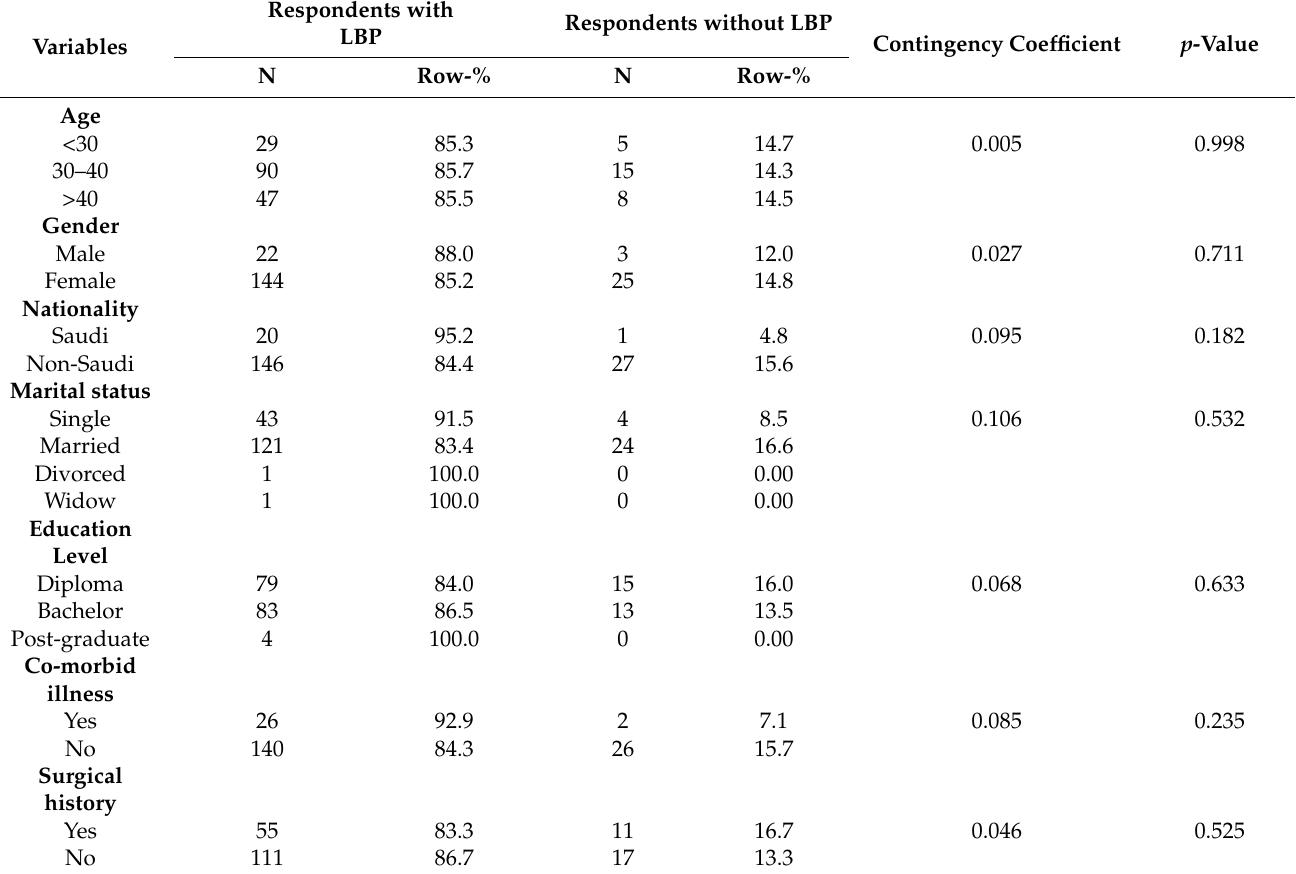
Table 5. Relationships between low back pain and risk factors among nurses in KAUH over the past 12 months.